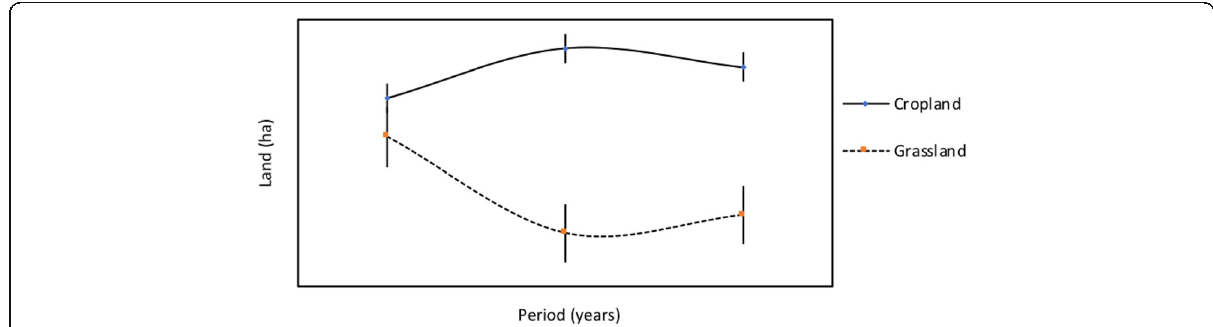
Fig. 4 Land-use/land cover changes in crop and grazing lands from 1984 to 2016. Vertical bars show standard errors of the